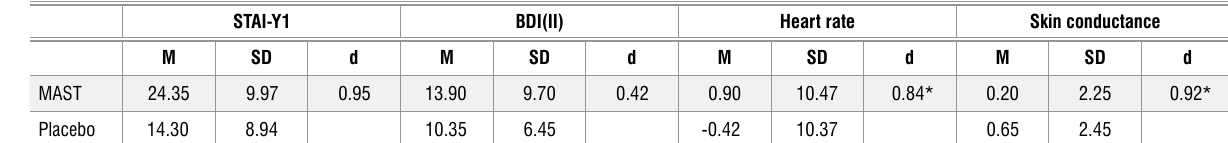
Figure 3: Disordinal heart rate x time and skin conductance x time interactions for the low (Placebo MAST) and high (MAST) stress groups in Experiment 1, showing averages and confidence Self-reported stress and depression scores by condition